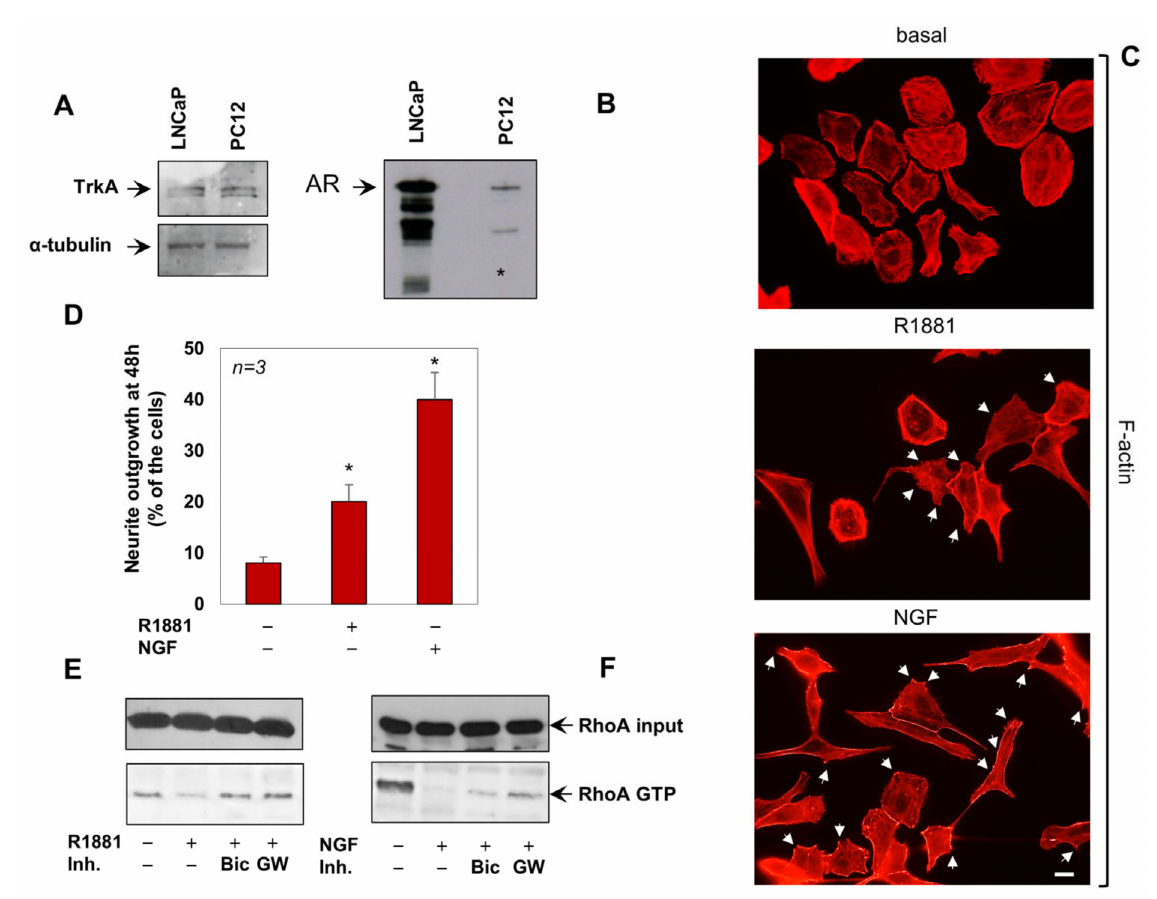
Figure 1. NGF and R1881 induce the RhoA inactivation and neurite outgrowth in PC12 cells. In ( A , B ), lysates proteins prepared from the indicated cell lines were analyzed by WB, using the antibodies against the indicated proteins. ( C ), PC12 cells were untreated or treated for 24 h with R1881 or NGF, stained for F-actin using Texas red–phalloidin and analyzed by IF. Images are representative of three independent experiments. Arrows indicate the dendritic spines. Bar, 10 µ M. ( D ), Neurite outgrowth was analyzed as reported in Methods. Data derived from three different experiments were analyzed and expressed as percentage of total cells. Means and SEM are shown; n represents the number of experiments; * p < 0.05. ( E , F ), cells were left untreated or treated for 5 min with R1881 (left) or NGF (right), in the absence or presence of Bicalutamide (Bic) and GW441756 (GW). The GTP-loaded form of RhoA (RhoA-GTP) was assayed as in Methods and revealed by WB. Loaded RhoA (RhoA input) was also detected, as